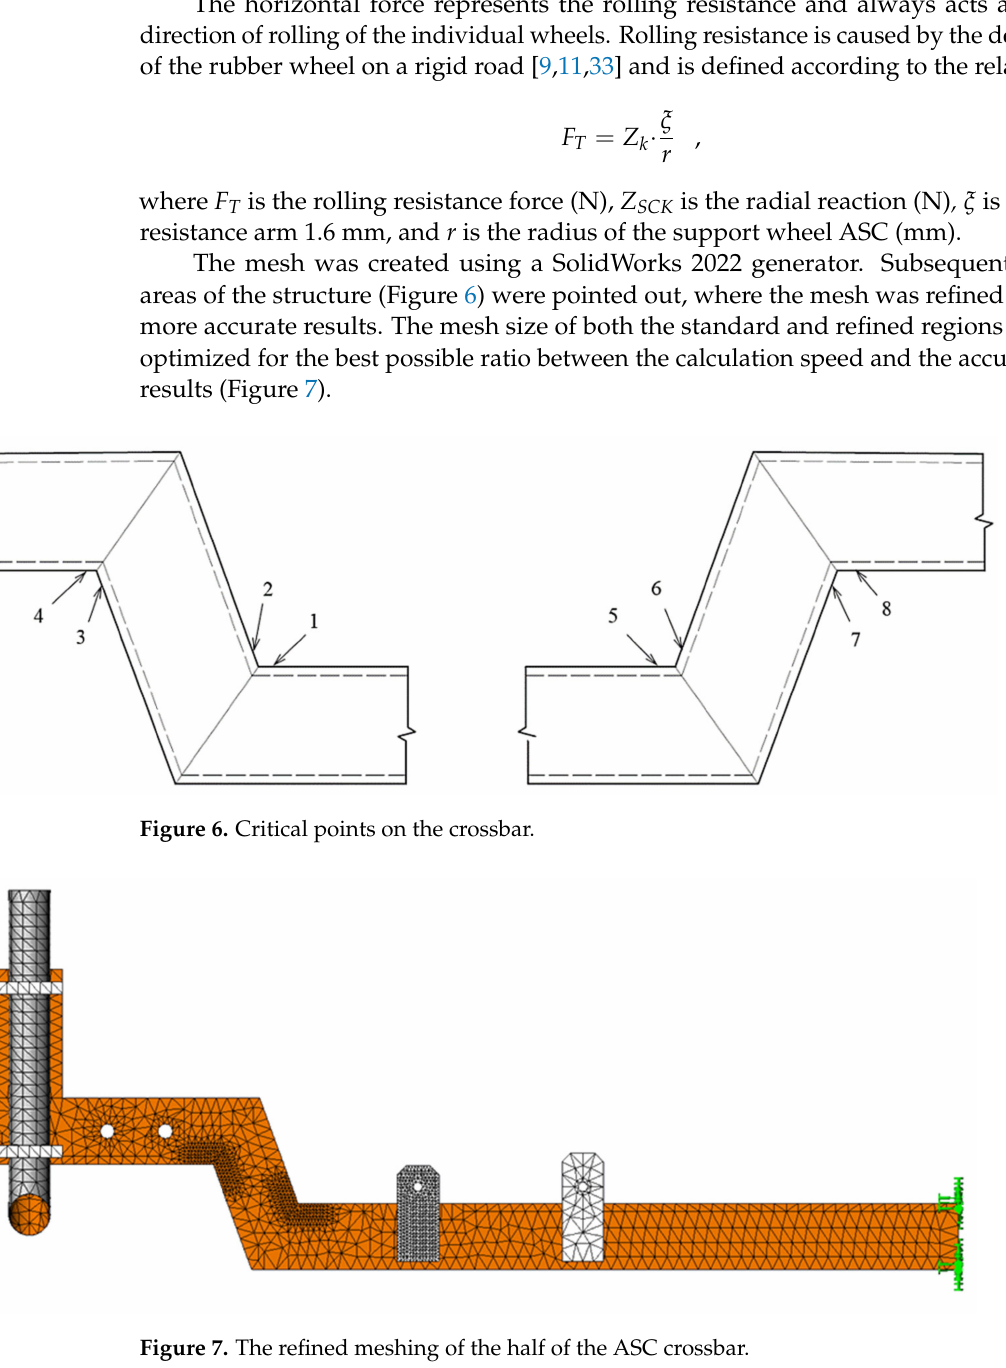
Figure 7. The refined meshing of the half of the ASC